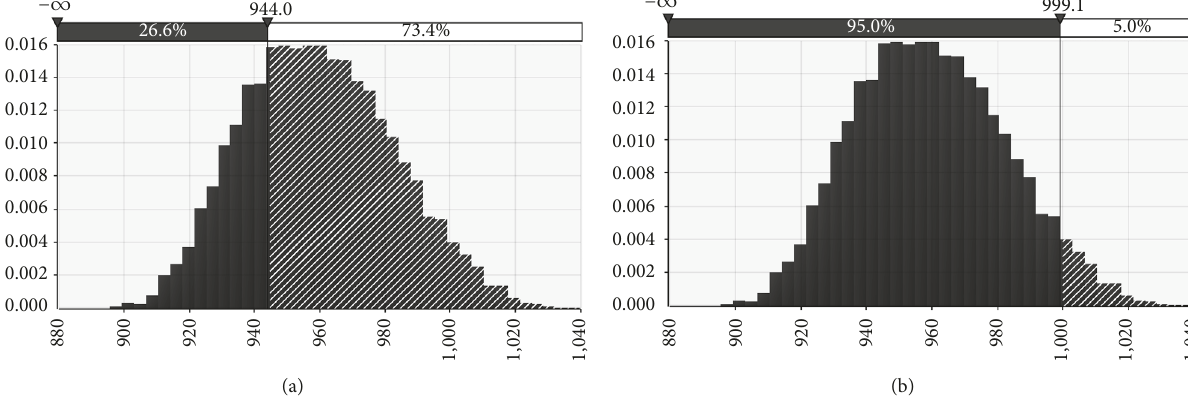
Figure 6: Relative frequency histograms of cost for the Cardenillo project. (a) Cost probability is equal to or less than US $ 944 million (BAC). (b) Cost calculated with 95% probability is equal to US$ 999.1